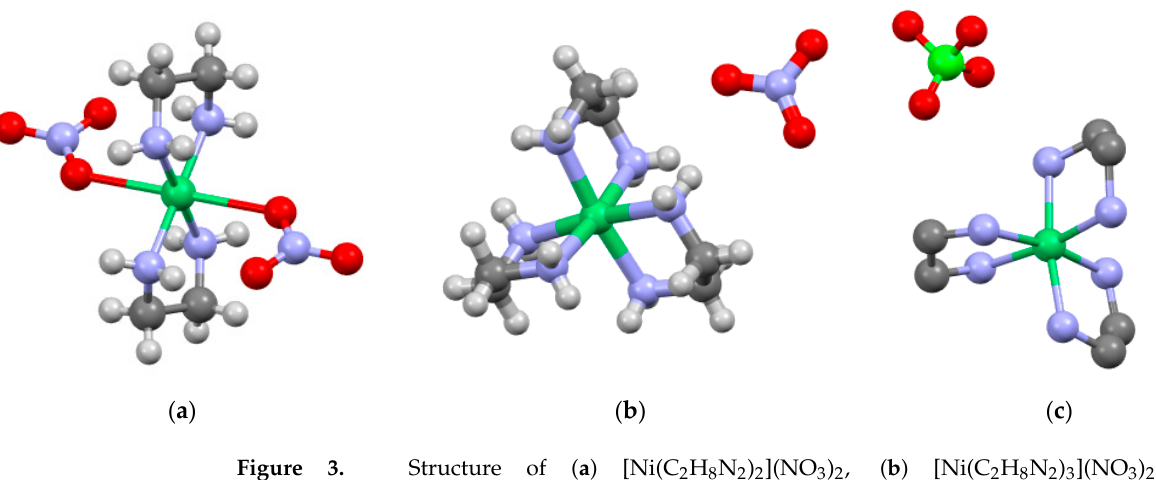
Figure 3. Structure of ( a ) [Ni(C 2 H 8 N 2 ) 2 ](NO 3 ) 2 , ( b ) [Ni(C 2 H 8 N 2 ) 3 ](NO 3 ) 2 and ( c ) [Ni(C 2 H 8 N 2 ) 3 ](ClO 4 ) 2 ( b ) [Ni(C 2 H 8 N 2 ) 3 ](NO 3 ) 2 and (without hydrogen) complexes: green—Ni 2+ ion; lilac—nitrogen atom; dark gray—carbon atom; ( c ) [Ni(C 2 H 8 N 2 ) 3 ](ClO 4 ) 2 (without hydrogen) complexes: green—Ni 2+ ion; lilac—nitrogen light gray—hydrogen atom; red—oxygen atom. atom; dark gray—carbon atom; light gray—hydrogen atom; red—oxygen